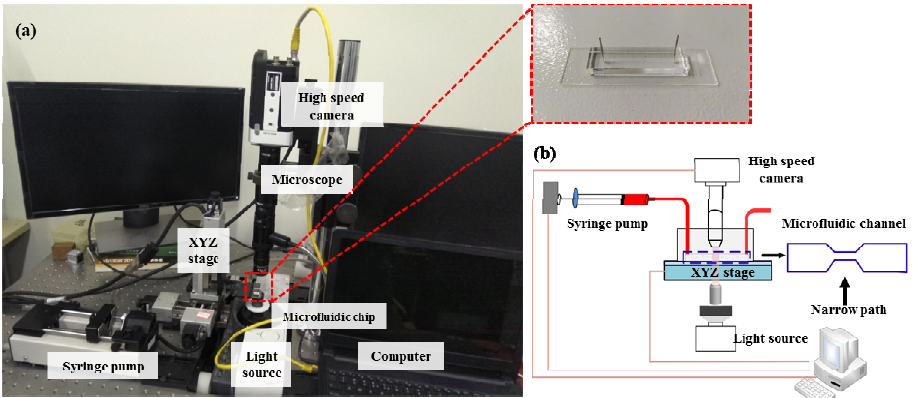
Figure 1. ( a ) The overview of the experimental system device (inset shows polydimethylsiloxane (PDMS) microfluidic chip), ( b ) its detailed work schematic diagram and microfluidic channel